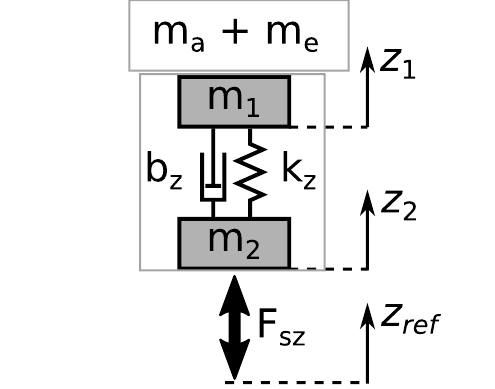
Figure 1. Dual-mass oscillator as a model for uniaxial force sen-